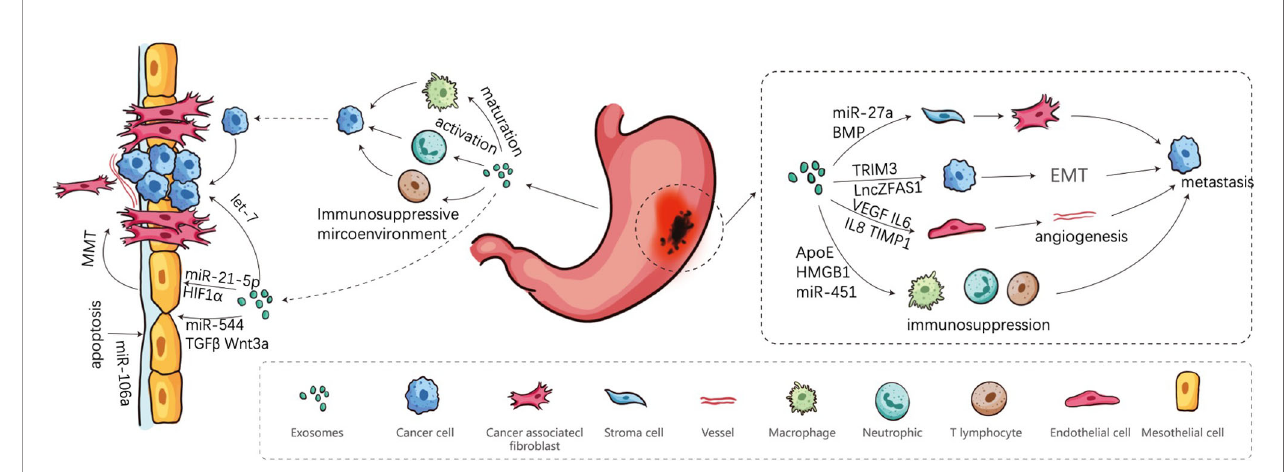
FIGURE 1 | Involvement of exosomes in peritoneal metastasis Cascade. Firstly, cancer cells are shed from the primary sites, and secondly transported in the peritoneal cavity. Finally, cancer cells adhere to the MCs and implant in